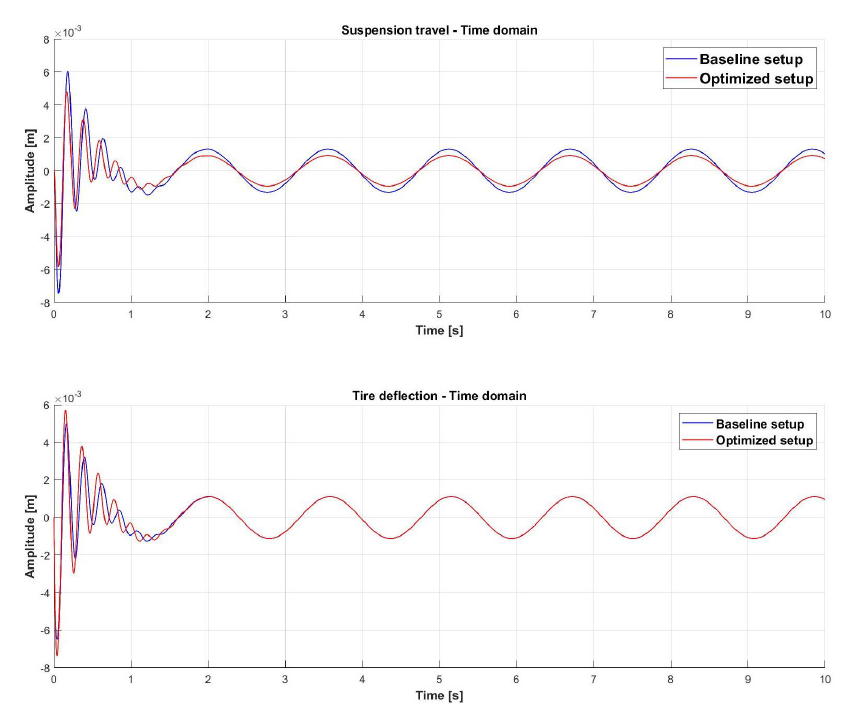
Figure 17. Comparison between baseline setup and optimized setup. The optimized setup is able to reduce the amplitude of suspension travel and tire deflection in the time